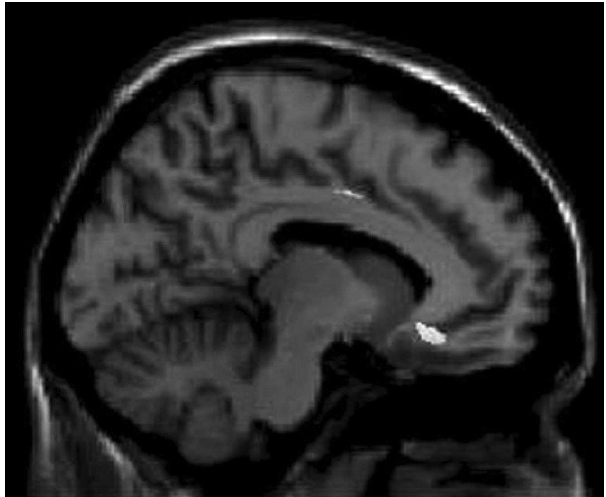
Figure 1 - Correlations between Neuropsychiatric Inventory scores and reduced gray matter volume in different areas of the brain. The results are displayed at an uncorrected l p , 0.001 level and plotted onto the SPM5 canonical T1 image for the purpose of